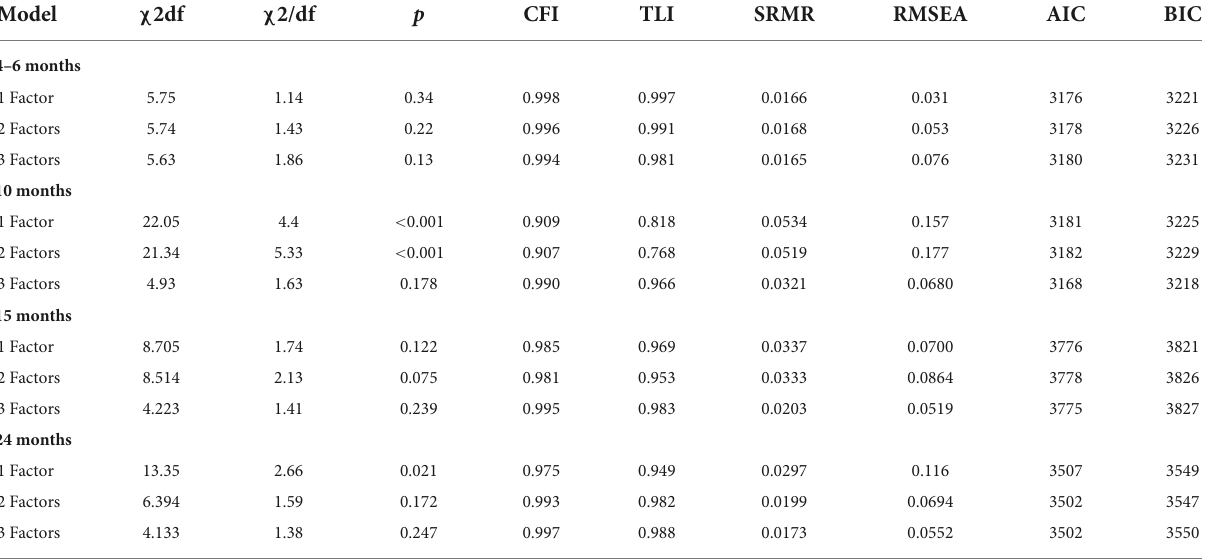
TABLE 5 Goodness-of-fit indices from CFA models by age